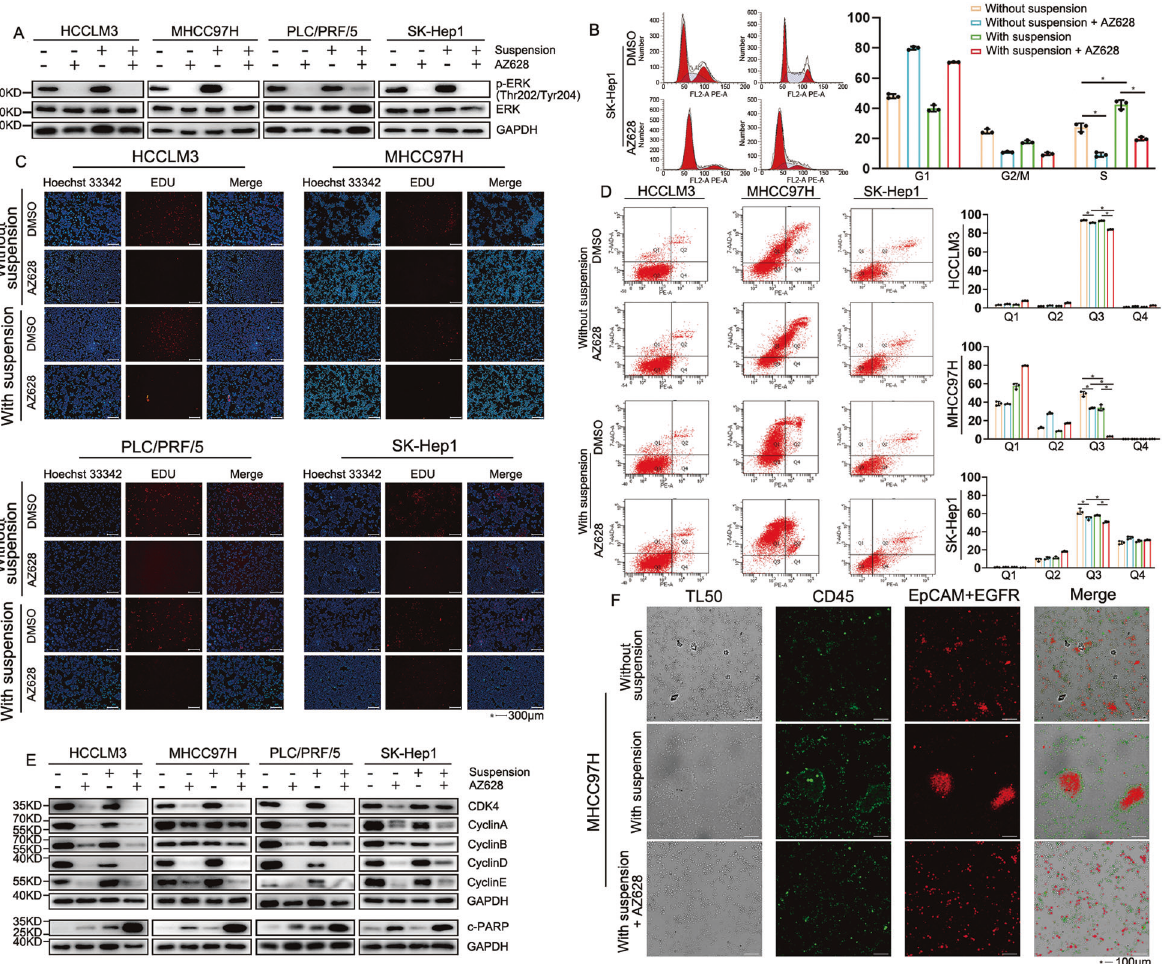
Fig. 5 Ras/MAPK pathway stabilized suspended HCC cell lines and avoid killing of leukocytes. Cells were divided in 4 groups: (a) cultured without suspension (b) cultured with suspension (c) cultured without suspension, 10 µM of AZ628 were used for Ras/MAPK pathway inhibition (d) cultured with suspension, 10 µM of AZ628 were used for Ras/MAPK pathway inhibition. Cells in different group were detected in ( A ) phosphorylation of ERK by Western blot, ( B ) cell cycle by fl ow cytometry, ( C ) DNA synthesis by EDU, ( D ) apoptosis by fl ow cytometry and ( E ) Cyclin, CDK4 and PARP by Western blot. F Immuno fl uorescence was used in determining interactions between MHCC97H and leukocyte with or without Ras/MAPK inhibitor. Data of fl ow cytometry are shown as the mean ± SD, n = 3. * P <